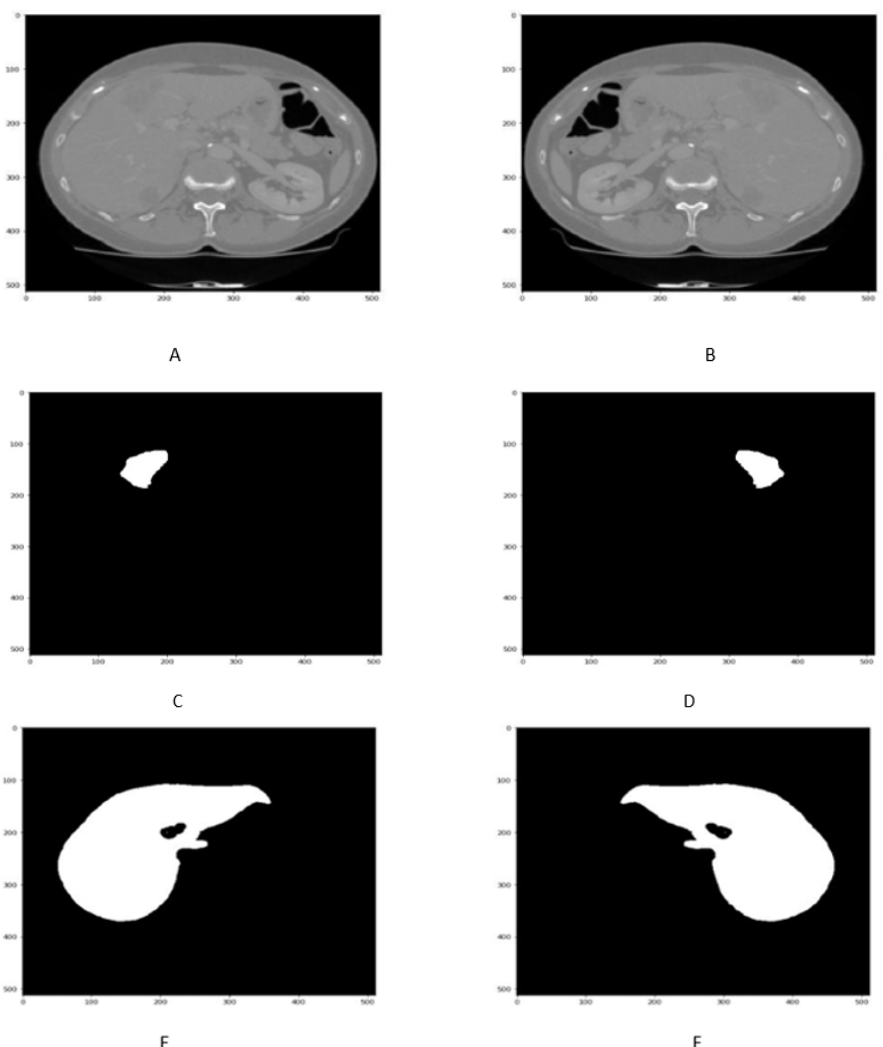
Figure 4. Figure shows that the Liver scan tumor mask before 90 ◦ in ( A , C , E ) While liver scan and tumor mask in ( B , D , F ) after